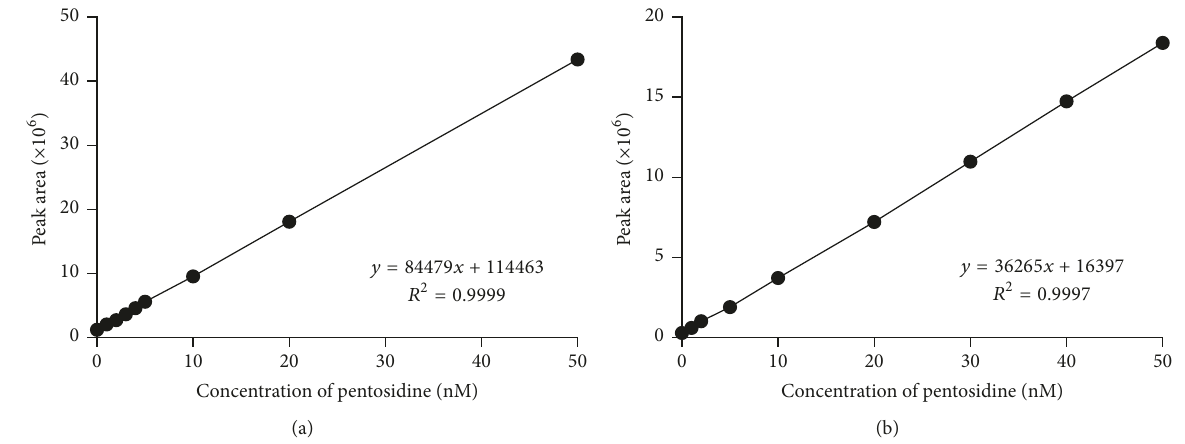
Figure 4: Linear regression and correlation coefficients (𝑅) of pentosidine at various concentrations in human urine (a) and plasma